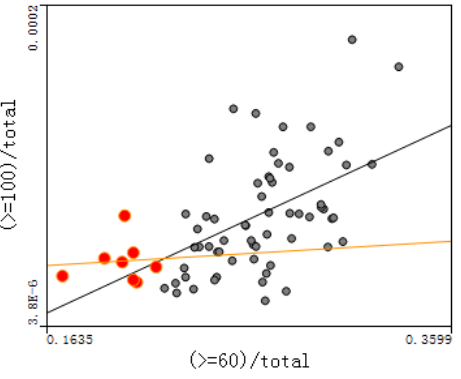
ratio and the degree of aging.